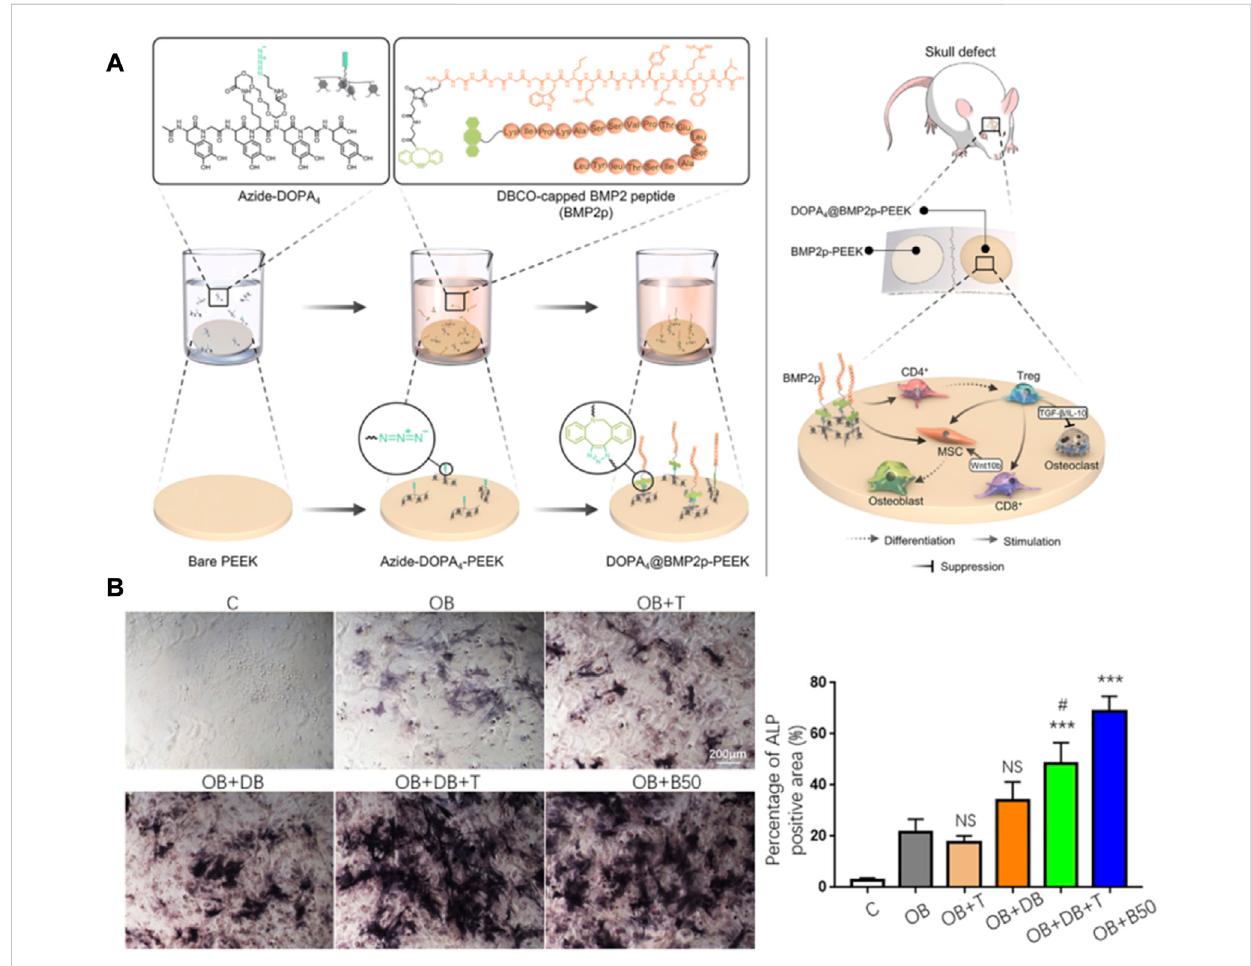
FIGURE 6 Immunomodulatory material for bone regeneration. (A,B) DOPA4@BMP2pPEEK material regulates the differentiation of CD4 T cells and synergizes with BMP-2 to promote bone regeneration. The graph was reprinted with permission from (Zhao et al.,